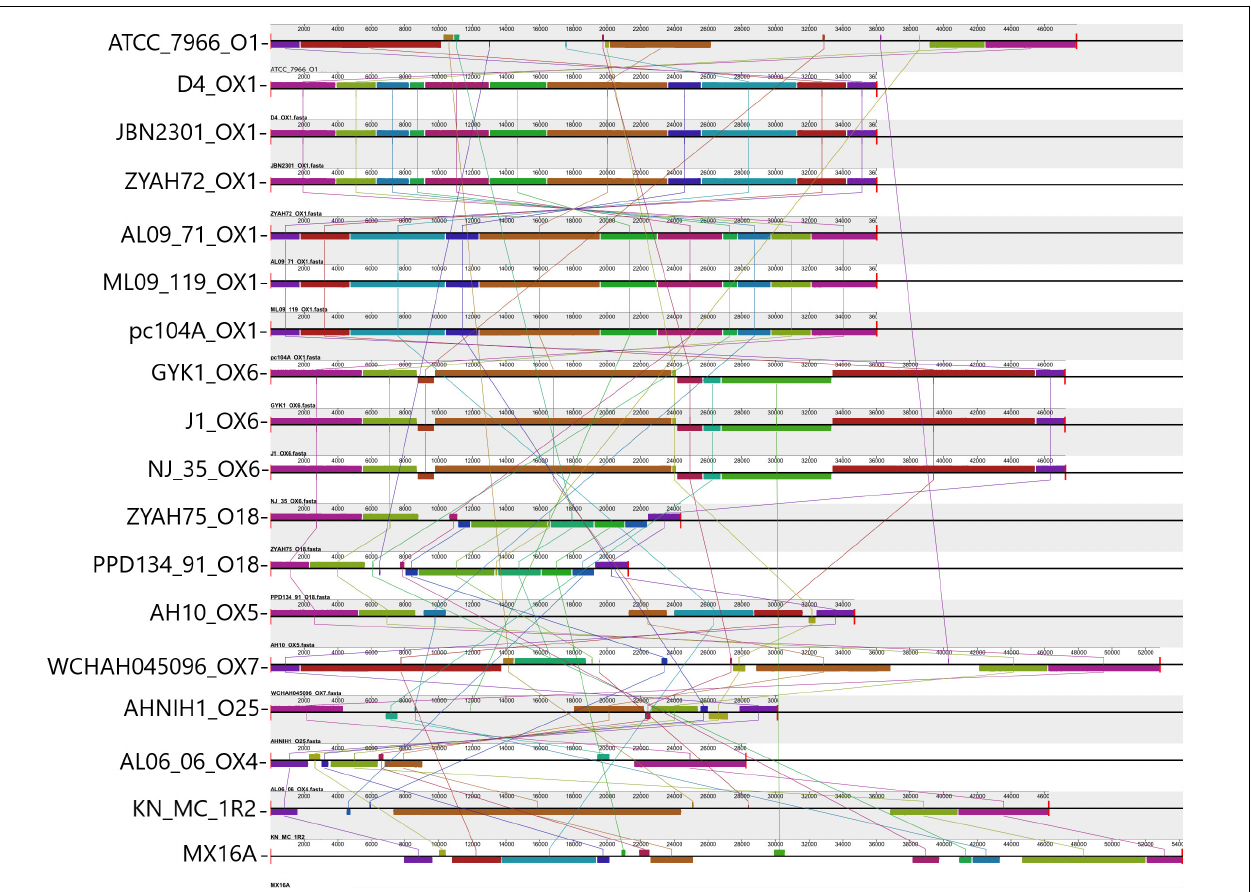
FIGURE 2 | Comparison of O antigen biosynthesis clusters encoded in predicted genomic islands (GIs). Alignment of the O Ag cluster from 17 A. hydrophila strains analyzed and strain PPD134-91. Blocks with the same color indicate homologous regions. The scale indicates the size of the cluster. Strain designations and respective serogroups are indicated below the representation of the cluster. Serogroups identified OX1 (D4, JBN2301, ZYAH72, AL09-71, ML09-119, pc104A); OX6 (GYK1, J-1, NJ-35); O18 (comparison between PPD134/91 serogroup O18, and ZYAH75 cluster); OX5 (AH10); OX7 (WCHAH045096); O25 (AHNIN1); OX4 (AL06-06); O1 (ATCC 7966); not determined (KN-MC-1R2, MX16A). The O Ag cluster of strains pc104a, AL09-71, and ML09-119 are in the reverse orientation in the genome of the strains. The name of each strain and the respective serogroup are indicated in front of the blocks representing the O Ag